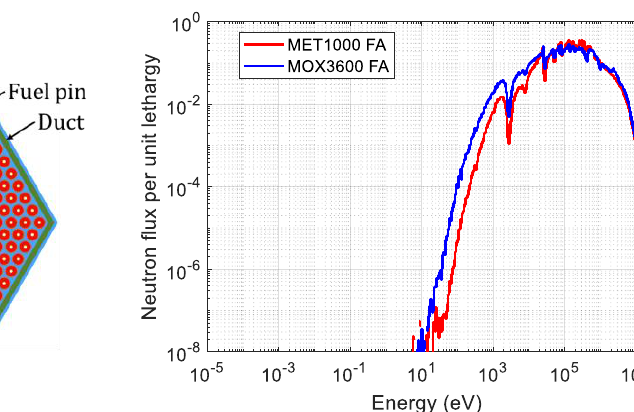
Figure 5. Configuration of fuel assembly models Figure 6. Neutron spectrum of fuel assembly Table II. Fuel assembly multiplication factor results